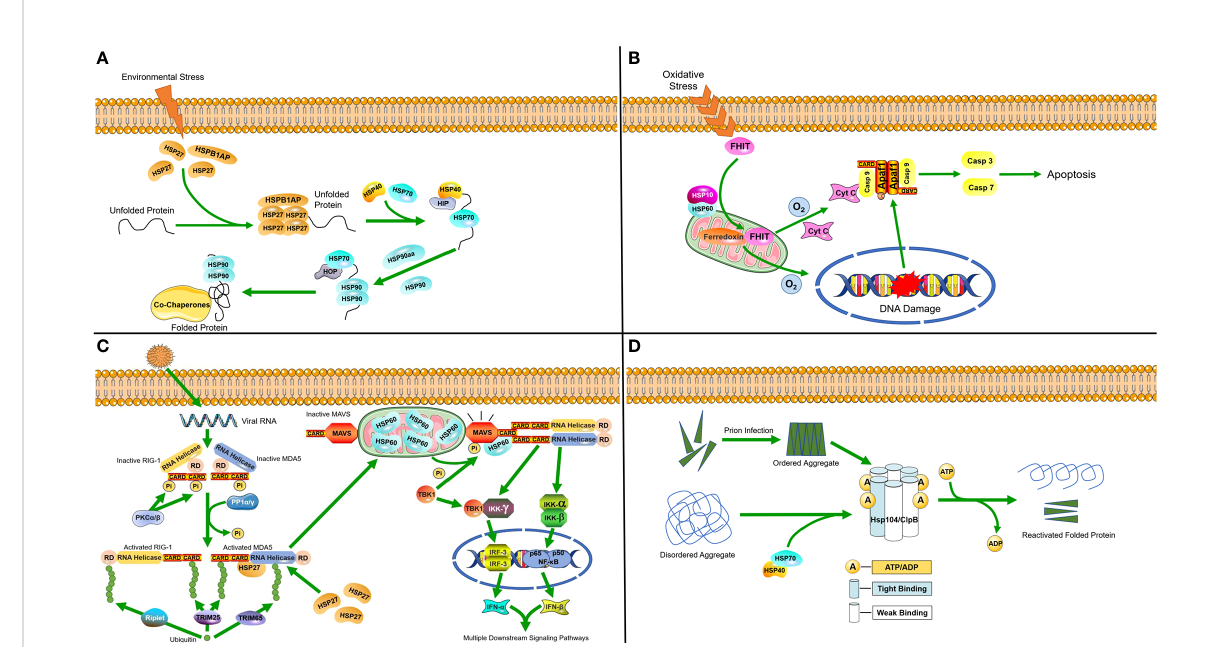
FIGURE 1 Molecular mechanisms of heat shock proteins induced under stress (A) Hsp27 binds to unfolded proteins that accumulate in the cytosol during stress, and then diverts unfolded proteins along the protein folding pathway, ultimately reaching HSP90. (B) In response to oxidative stress, the HSP60-10 complex helps to localize FHIT protein to the mitochondria, where it stabilizes ferredoxin reductase, leading to enhanced production of reactive oxygen species. This in turn triggers cytochrome c release and subsequent activation of the caspase cascade, ultimately causing apoptosis. (C) Following viral invasion, the RLR/MDA5 signaling pathway is activated. HSP27 can speci fi cally stabilize MDA5 during expression to enhance the RLR/MDA5 signaling pathway. In mitochondria, HSP60 interacts with MAVS to increase MAVS-mediated IFN- b promoter activity and the transcriptional levels of IFN- b . Furthermore, it can upregulate MAVS-induced mRNA transcription of IFN-stimulated genes (ISGs). (D) Hsp104/ClpB complexes in host cells process disordered aggregates accumulated following cellular stress as well as ordered aggregates formed after prion infection with the help of the HSP70-40 partner system, dissociating them into component proteins and reactivating